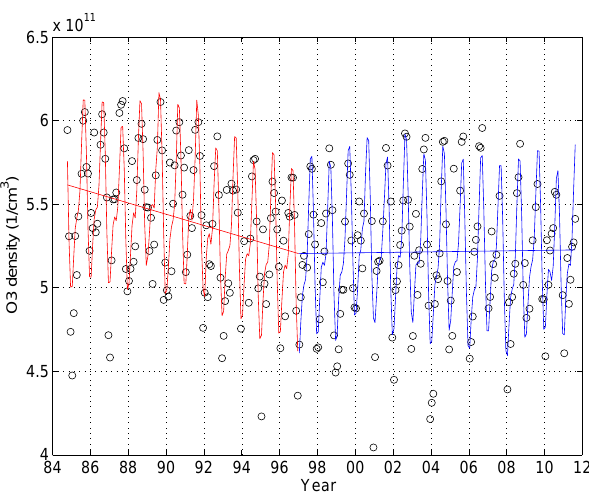
Fig. 13. The relative contribution of the solar proxy (%) with re- spect to the constant term for 1984–2011. Shaded areas show re- gions where trends are statistically different from zero at the 95% level.